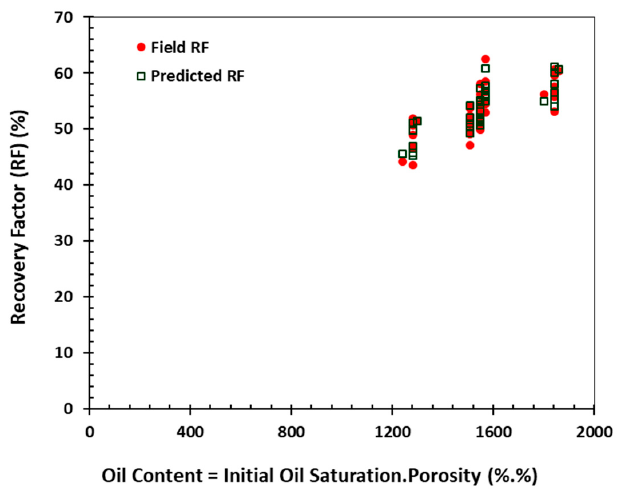
Energies 2018 , 11 , x FOR PEER REVIEW Figure 17. RF vs. Producibility factor for the database analyzed. Figure 18. RF vs. producibility factor for the database analyzed.